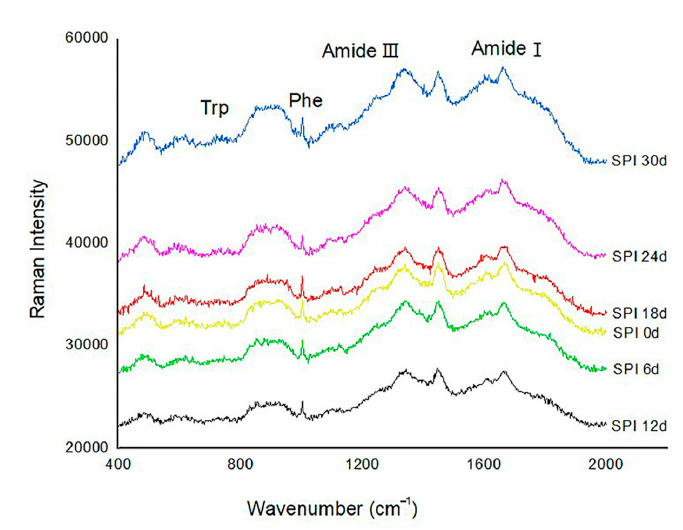
Figure 2. Raman spectra in the 400–2000 cm − 1 region from SPI with di ff erent storage times. Table 2. The relative content of secondary structures of SPI with di ff erent storage times. The Relative Content of Secondary Structures (%) Storage Time (day) α -Helix β -Sheet β -Turn Random